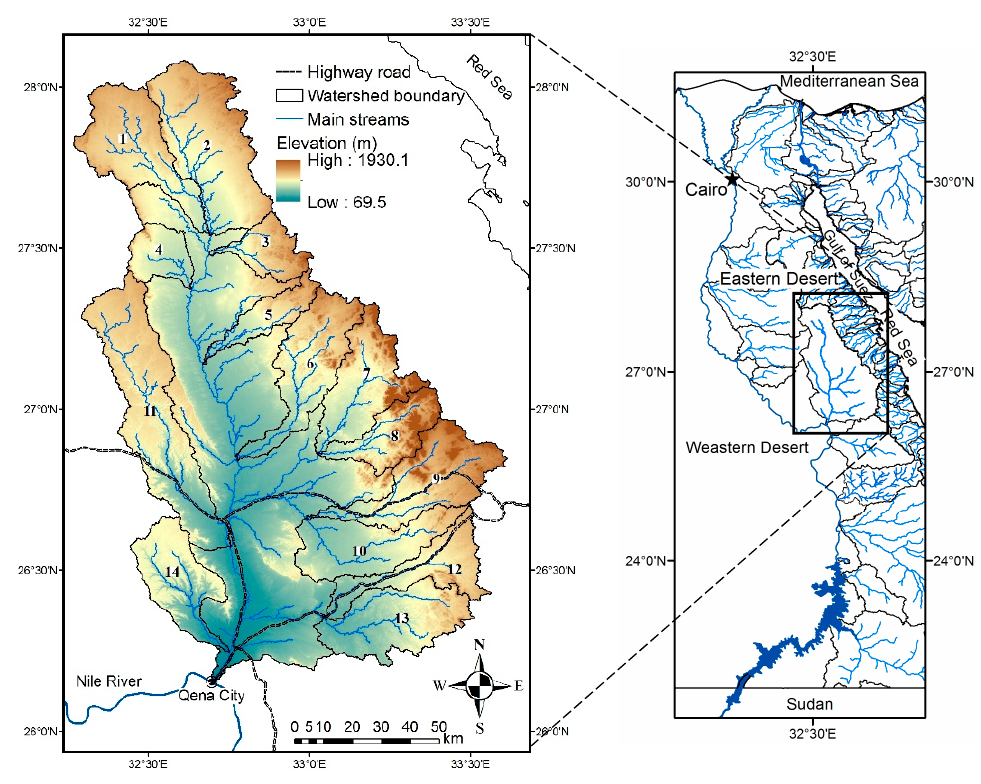
Figure 1. Location map of Wadi Qena showing the existing highway roads, target sub-basins, main streams and its topography with the main drainage systems of Egypt in the Eastern Desert and Sinai Peninsula.